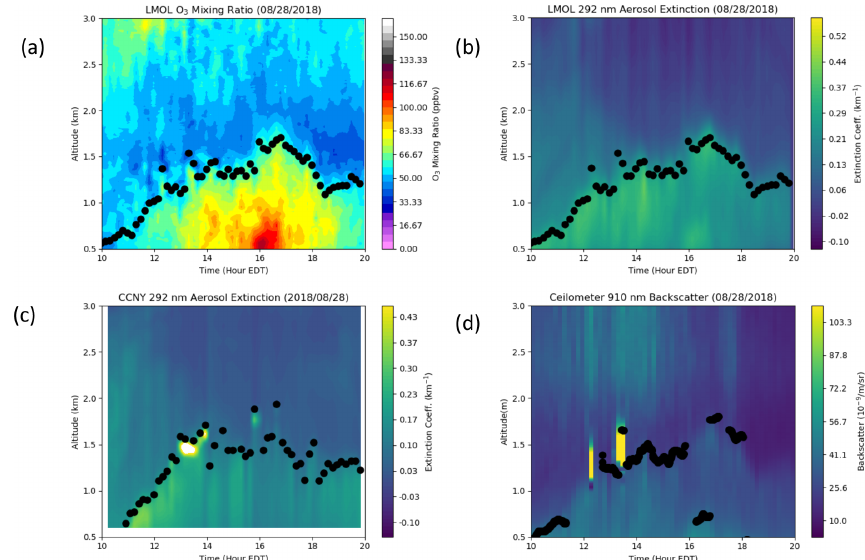
Figure 7. (a) The O 3 variation, (b) the retrieved LMOL UVB aerosol extinction coefficient curtain plot, (c) the CCNY lidar aerosol extinction coefficient (converted to 292nm), and (d) the 910nm ceilometer CL51 (same location as LMOL) backscatter for 28 August 2018. The black dot on the curtain plots in panels (b)–(d) shows the PBL